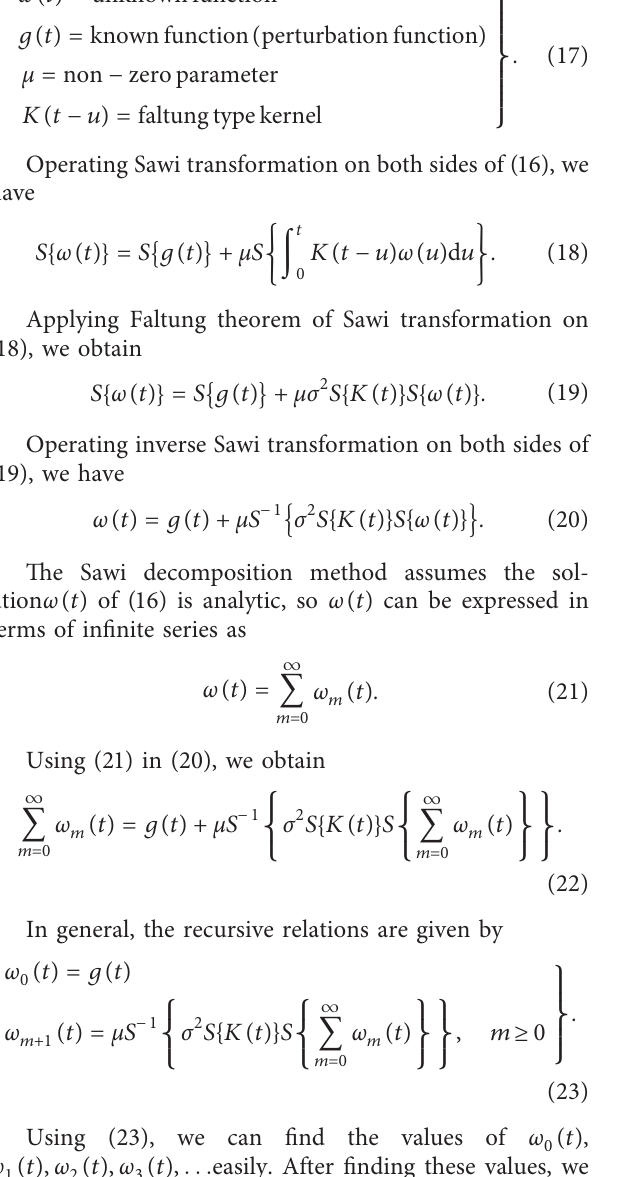
Table 1: Sawi transformation of frequently used functions